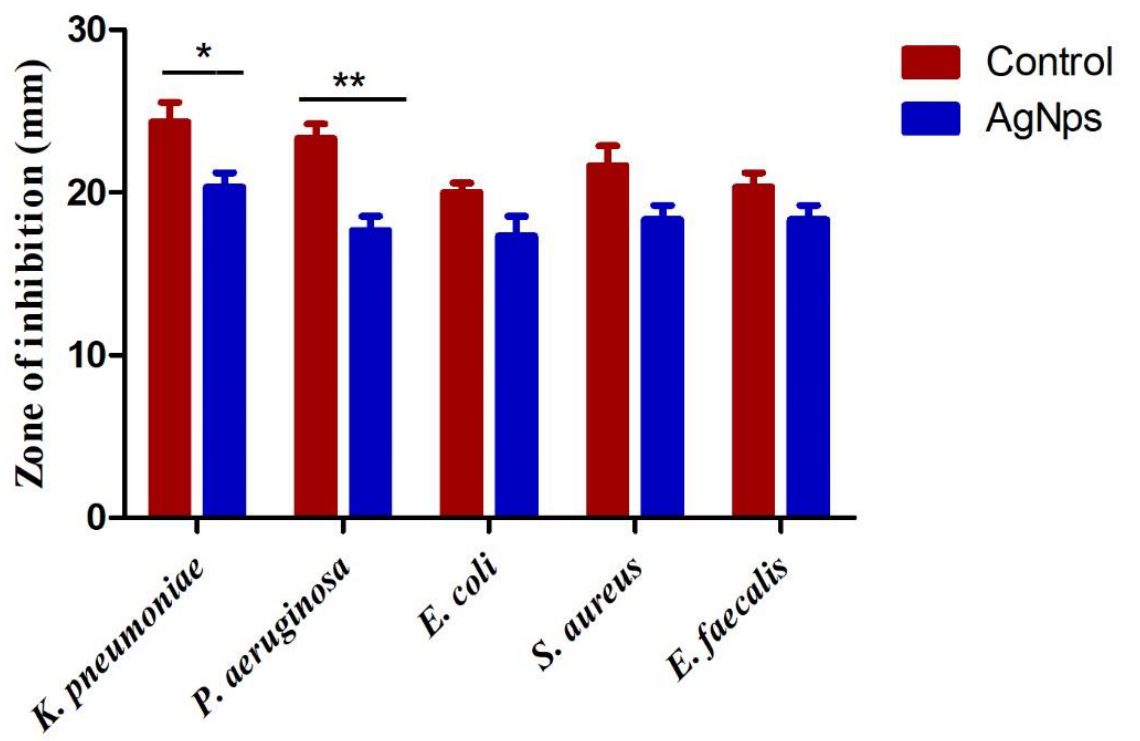
Figure 5. Assessment of anti-bacterial activity of Aw–AgNPs (100 µg/mL) and positive control, penicillin. Values expressed as mean ± SE of the mean ( n = 3). * Denotes significant difference of positive control (penicillin) with test samples at p < 0.05 and ** p < 0.01.